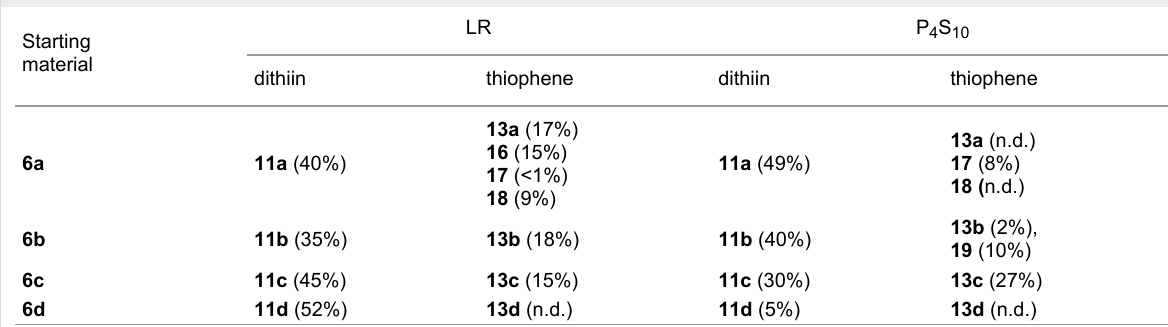
Table 1: Ring closure methods and product